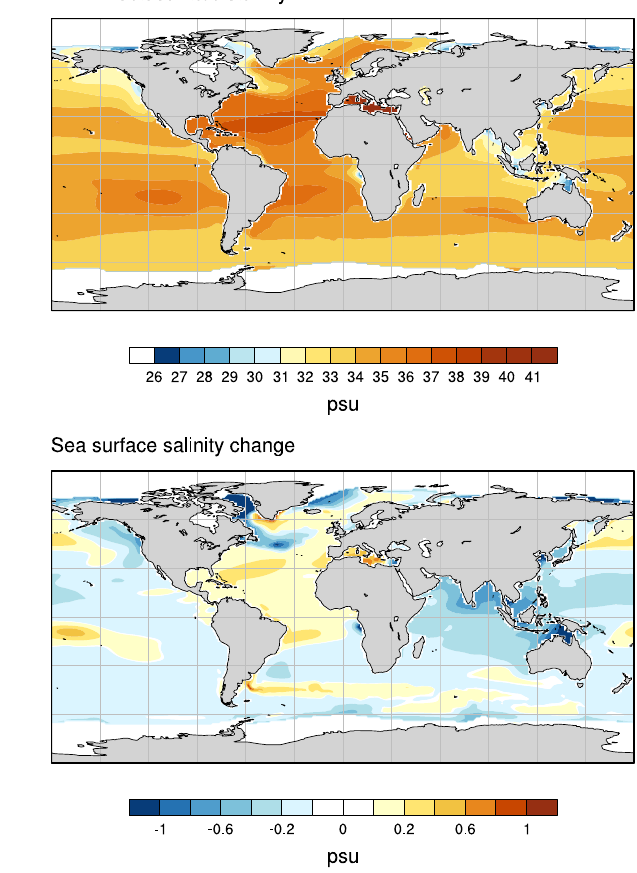
Fig. 5. CCSM4 simulated mPWP SST ( ◦ C) (top) and change from PI control (bottom). White regions indicate sea ice in the mPWP simulation (top) and both the mPWP and PI simulations (bottom). Proxy data are plotted as open circles; color code indicates temper- ature change ( ◦ C) from present day.